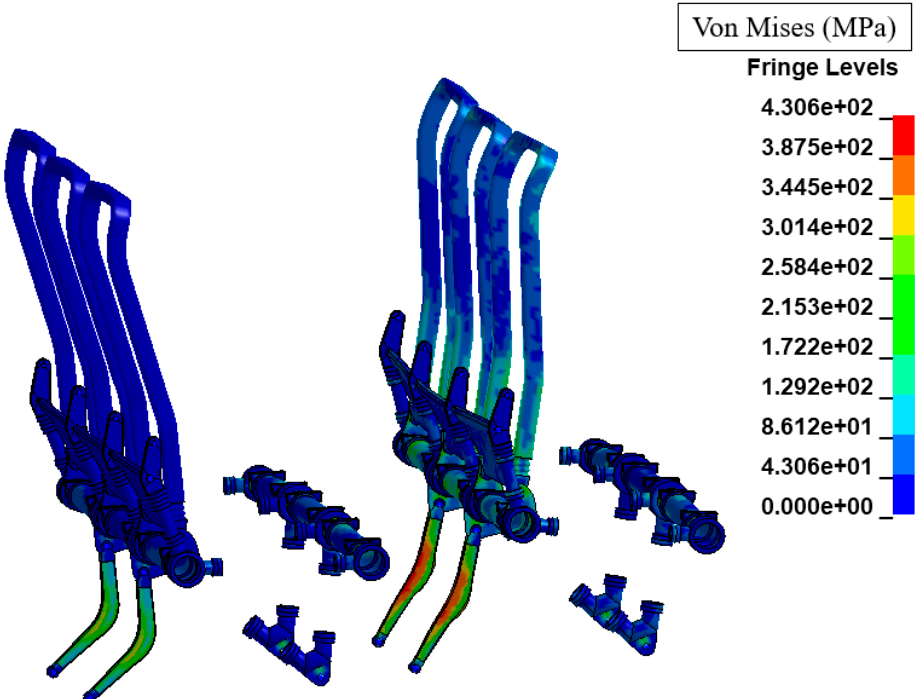
Figure 13. Maximum stress of the primary loading path’s metal components for test 3. Table 10. Isotropic material safety factor against the fraction for test 3.